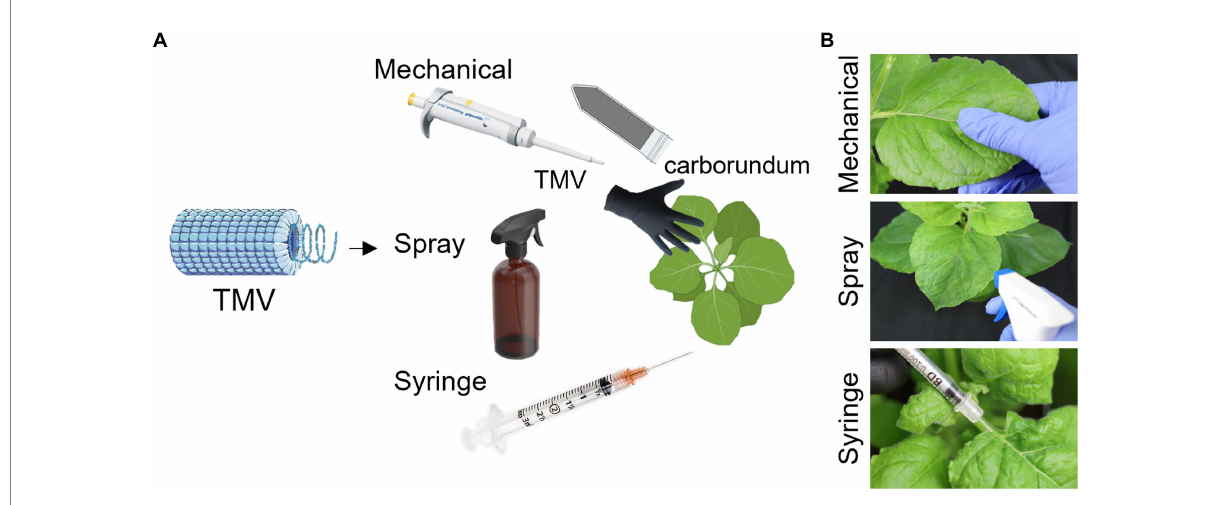
FIGURE 1 Schematic representation of the experimental design. TMV was used as a model to test mechanical, spray, and syringe inoculation (A) . Photographs demonstrating the applications of TMV via mechanical, spray, and syringe inoculation (B) . The plants from